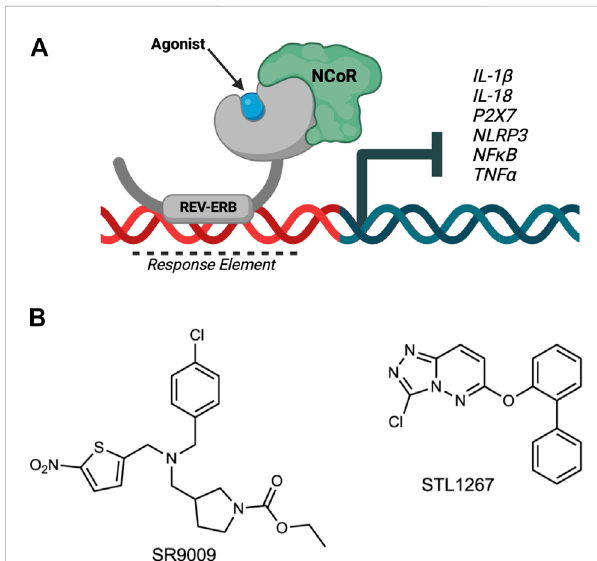
Overview of REV-ERB regulation of in fl ammatory components involved in pain. (A) The nuclear receptor REV-ERB recognizes sequenceswithinthepromoterofitstargetgenes(ResponseElement) and binds DNA via its DNA-binding domain. Upon binding of a ligand, REV-ERB undergoes a conformational change and recruits the NCoR corepressor, causingtherepression oftranscription of itstarget genes including NLRP3, IL-1 β , and other pro-in fl ammatory cytokines and pathway genes. (B) Structures of two REV-ERB agonists: SR9009 and